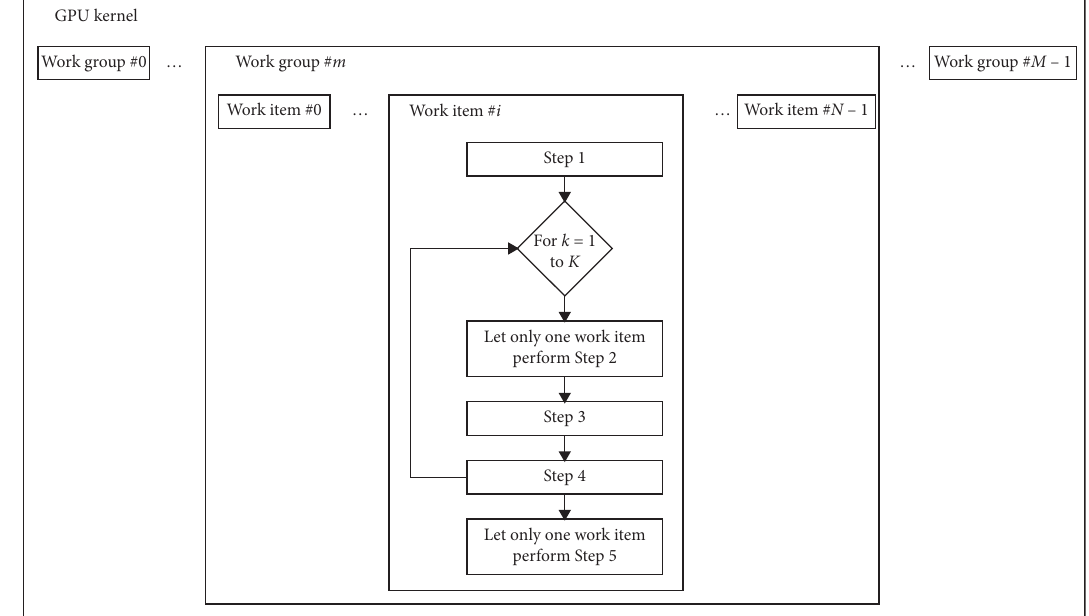
Figure 5: Coarse-grained multipopulation